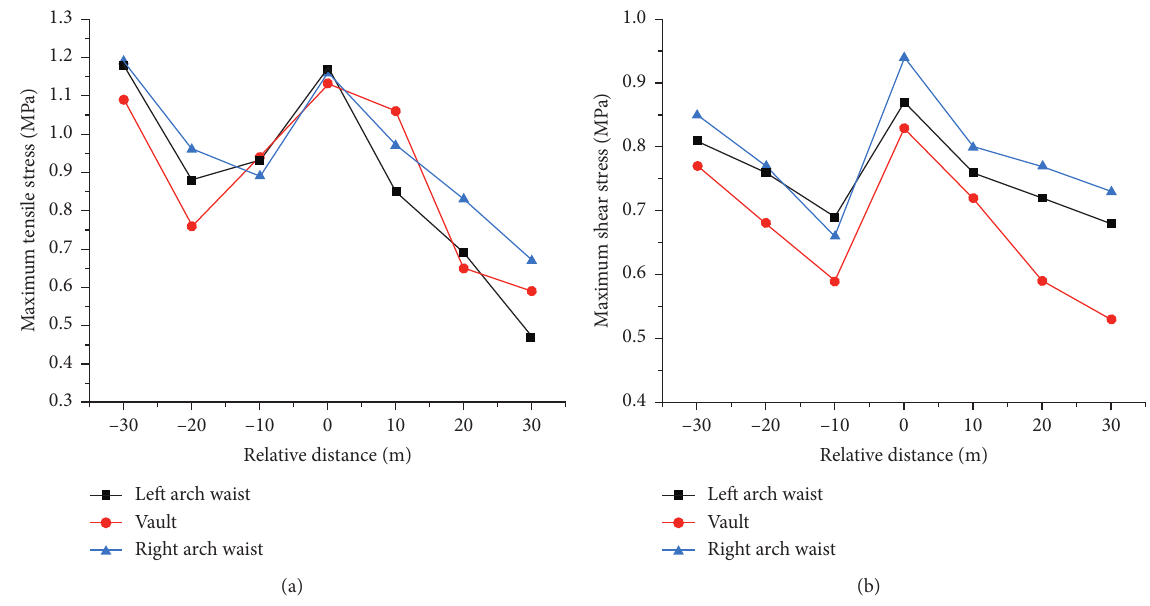
Figure 10: Stress attenuation curve of the lining: (a) maximum tensile stress and (b) maximum shear